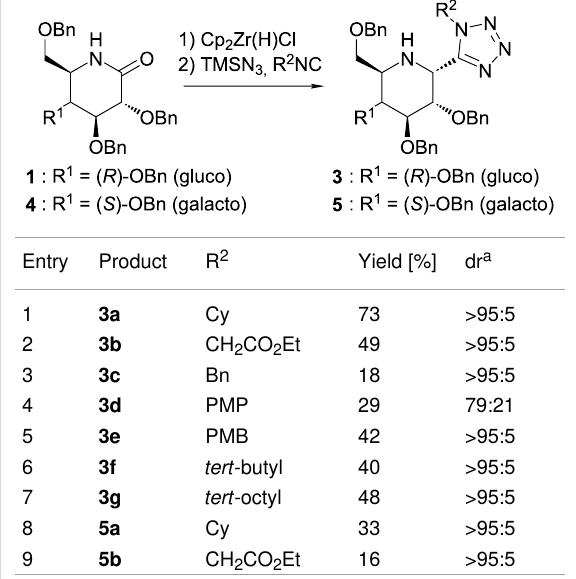
Table 2: Synthesis of 2-(1 H -tetrazol-5-yl)-iminosugars using optimized conditions. Reaction yield and dr are